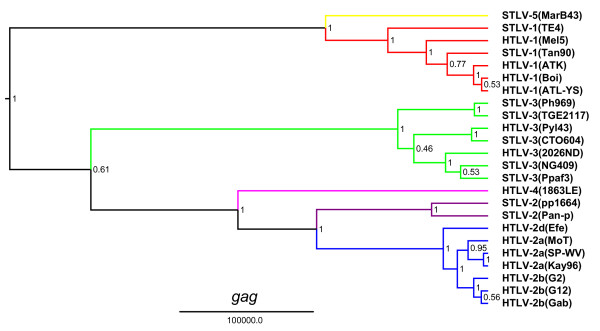
Phylogenetic relationship of HTLV-4(1863LE) to other PTLVs in gag using Bayesian inference. First and second codon positions of gag were used to generate PTLV phylogenies by sampling 10,000 trees with a Markov Chain Monte Carlo method under a relaxed clock model, and the maximum clade credibility tree, i.e. the tree with the maximum product of the posterior clade probabilities, was chosen. Branch lengths are proportional to median divergence times in years estimated from the post-burn in trees with the scale at the bottom indicating 100,000 years. Posterior probabilities for each node are indicated. Branches leading to PTLV-1, HTLV-2 and PTLV-3 sequences are drawn in red, blue and green respectively. The branch leading to HTLV-4(1863LE), STLV-2, and to the divergent MarB43 strain are drawn in magenta, purple, and yellow respectively.